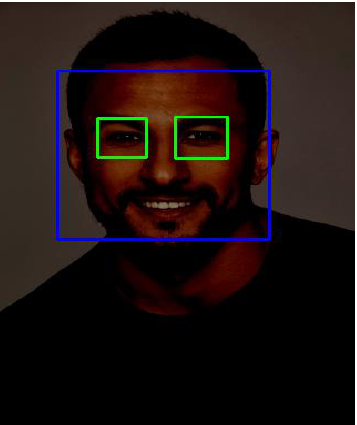
Figure 25. Slightly reduce the brightness in Figure 23.